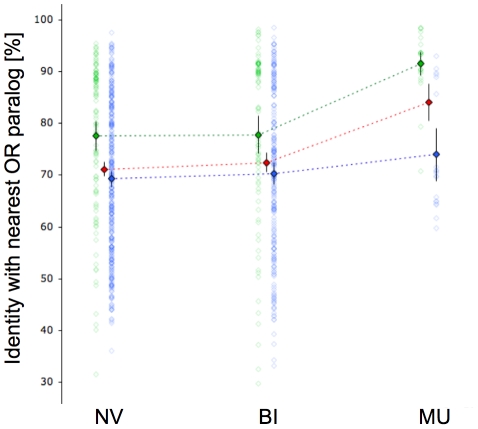
Analysis of ‘young’ and ‘ancient’ ORs.The figure displays the distribution of sequence identities with the most similar (‘nearest’) paralog for non-variable, bi-allelic, and multi-allelic OR loci. Each point represents the sequence identity of an OR to its nearest paralog (y-axis), and the type of locus (non-variable, NV; bi-allelic, BI; multi-allelic, MU). Green points: OR locus lacks a one-to-one ortholog in the chimpanzee genome; blue points: OR locus has a one-to-one ortholog in the chimpanzee genome (as assessed by comparing human and chimpanzee ORFs at the DNA level using BLAST, and classifying as one-to-one orthologs sequences displaying mutually highest sequence identity). Blue and green rhomboids represent the corresponding distribution average; red rhomboids represent averages for NV, BI, and MU. Rhomboid error bars represent 95% confidence intervals of the average.